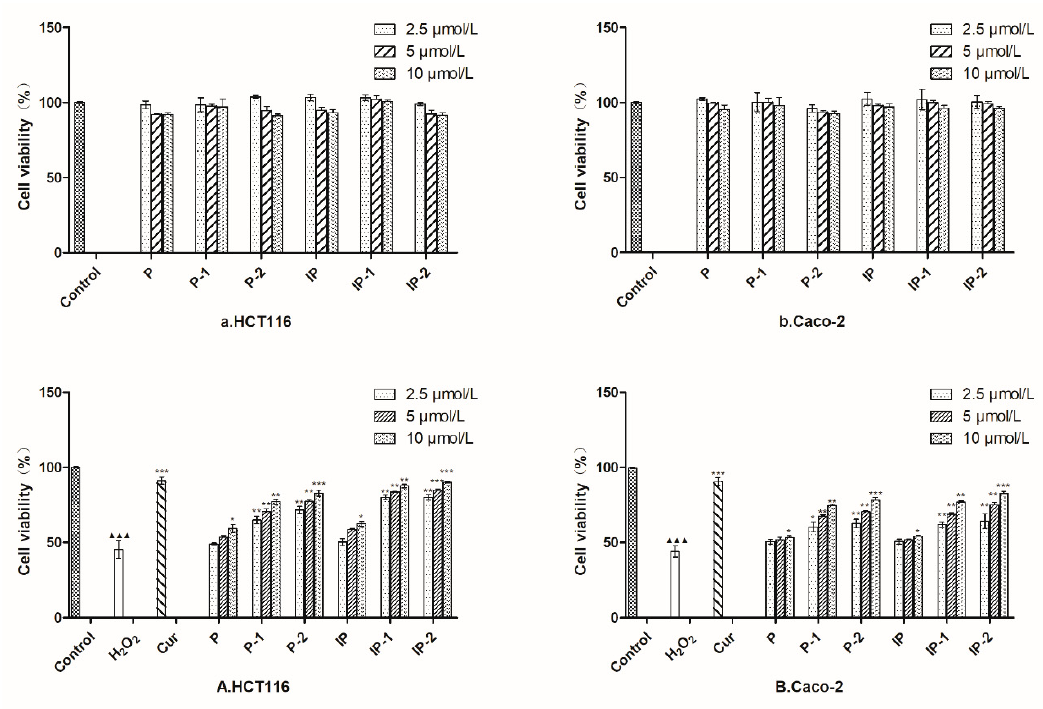
Figure 5. Cytotoxicity (( a ) for HCT116 cell line; ( b ) for Caco-2 cell line) and the protect effects against H 2 O 2 -induced oxidative damage (( A ) for HCT116 cell line; ( B ) for Caco-2 cell line) of P, IP, and their transformation products. The Cur group was the positive control group. Data are shown as the mean ± SD ( n = 3). ▲▲▲ p < 0.001 vs control group; * p < 0.05, ** p < 0.01, *** p < 0.001 vs the H 2 O 2 group.